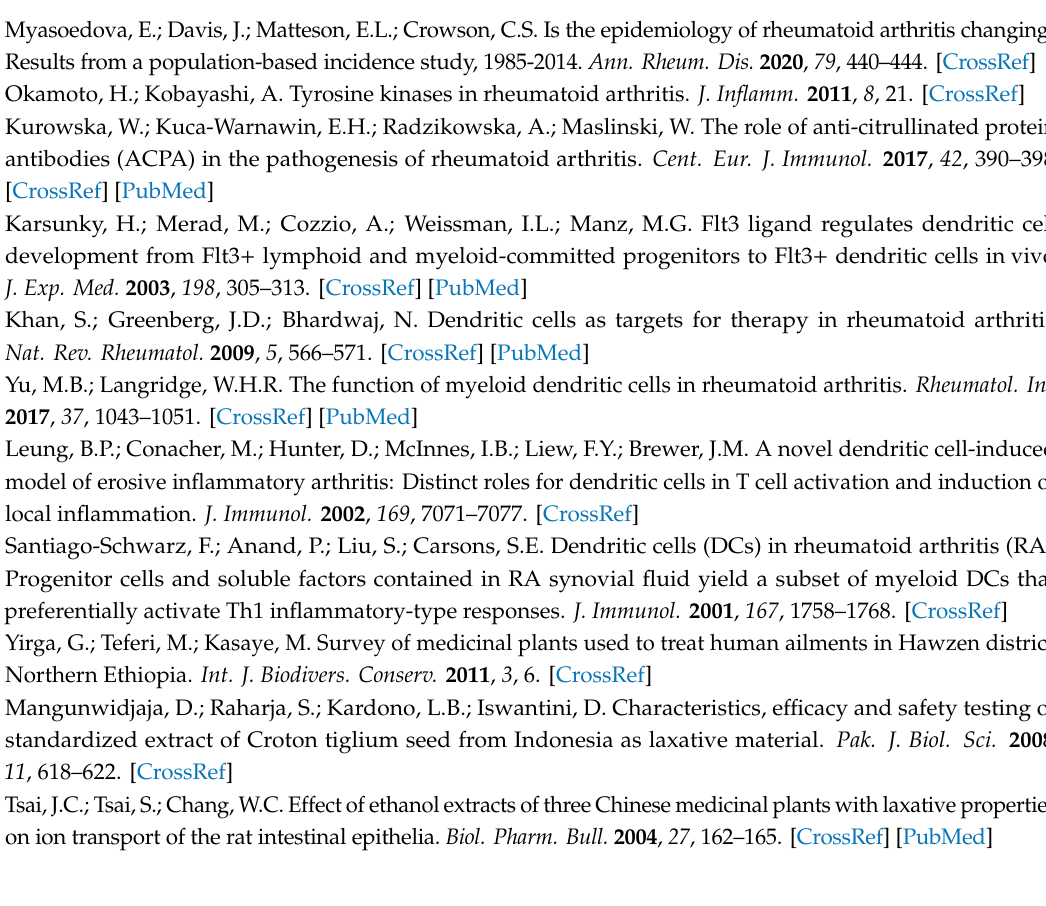
Figure S1: Representative bivariate graphs of co-stimulatory molecule, CD40, CD80, and MHC-II expressions of splenic CD11c + DCs from CIA mice obtained on day 42 after CIA experiments, Figure S2: Representative bivariate graphs of (A) IFN- γ and (B) IL-17A expressed splenic CD4 T cells from one of six CIA mice after CII-stimulation and crotonoside treatments followed by analyzing with flow cytometry, Figure S3: Cell viability and cytokine production of DCs after crotonoside treatment. LPS-stimulated, crotonoside-treated BMDCs, except DMSO mock control, were examined for (A) cell viability by CCK-8 (B) LDH assay and (C) cytokine productions by ELISA, Figure S4: Phosphorylation of MAPKs in activated BMDCs. (A) Levels of phosphorylated p38, JNK, and ERK from LPS-stimulated BMDC cellular lysates at indicated time points with or without crotonoside (50 µ M) were analyzed by Western blotting and quantified the intensity of bands in panel (B). Representative images from three independent experiments with similar results and GAPDH were used as loading